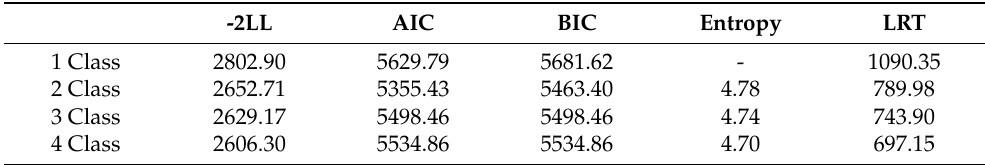
Table 2. Indices of the latent classes analysis model. -2LL AIC